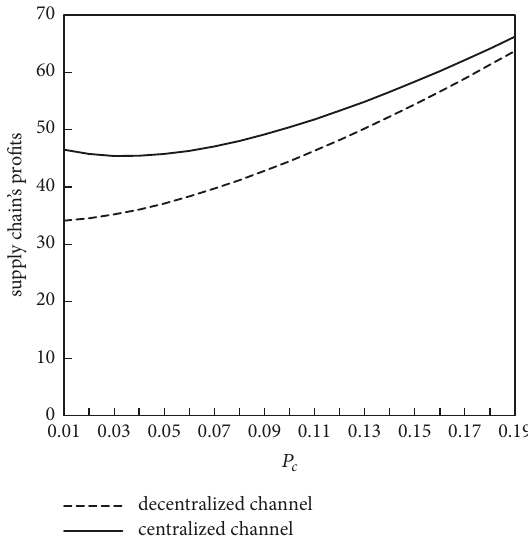
Figure 5: Supply chain’s profits under different carbon prices.